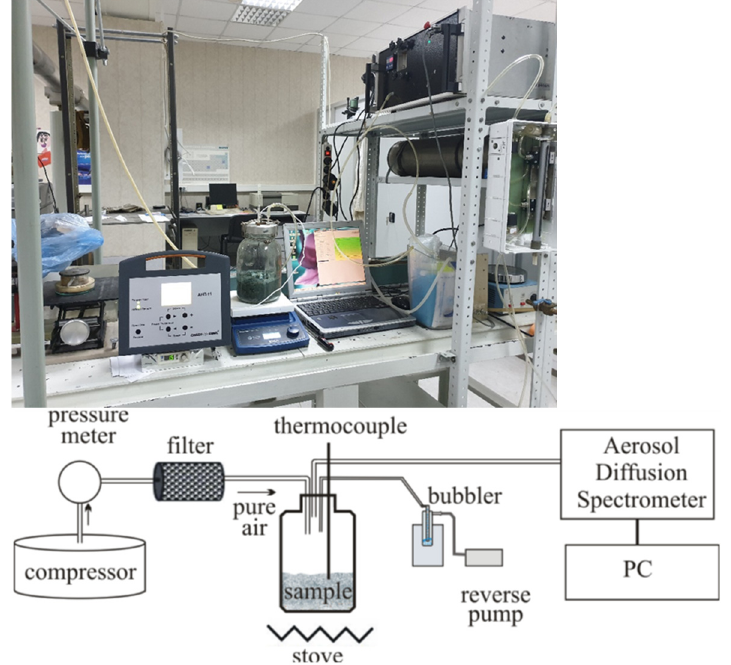
Figure 1. Photograph and scheme of the experiment setup.